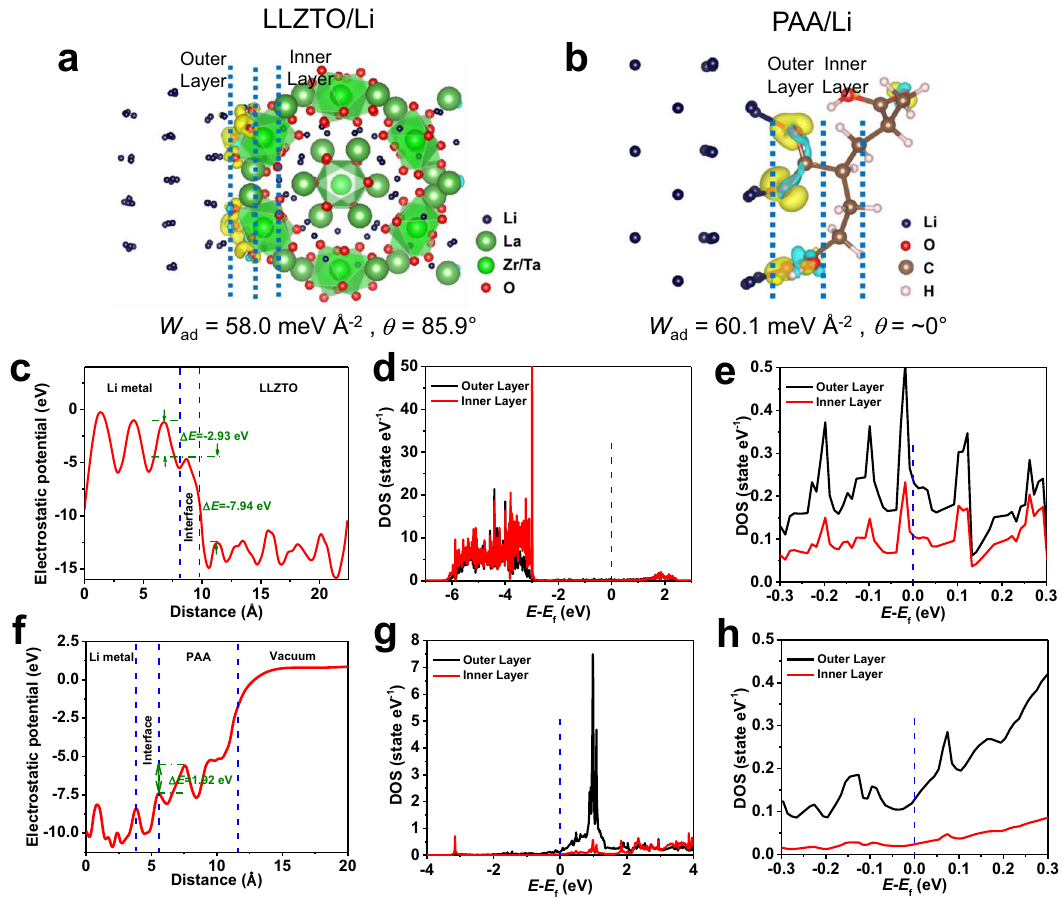
Fig. 2 Electron-blocking property of the PAA-modi fi ed LLZTO with Li metal. a The structure and charge transfer, c the electrostatic potential pro fi les, and d , e the density of states (DOS) for fully relaxed LLZTO(110)/Li(001). b The structure and charge transfer, f the electrostatic potential pro fi les, and g , h the density of states (DOS) for fully relaxed PAA/Li(001) single chain (the vacuum slab is not entirely presented in the